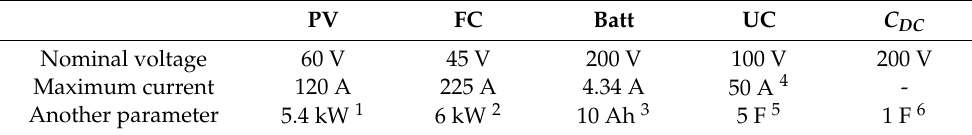
Figure 1. PV/FC/ESS hybrid power system. The parameters of the PV/FC/ESS hybrid power system are mentioned in Table 1. Table 1. Parameters of the PV/FC/ESS hybrid power